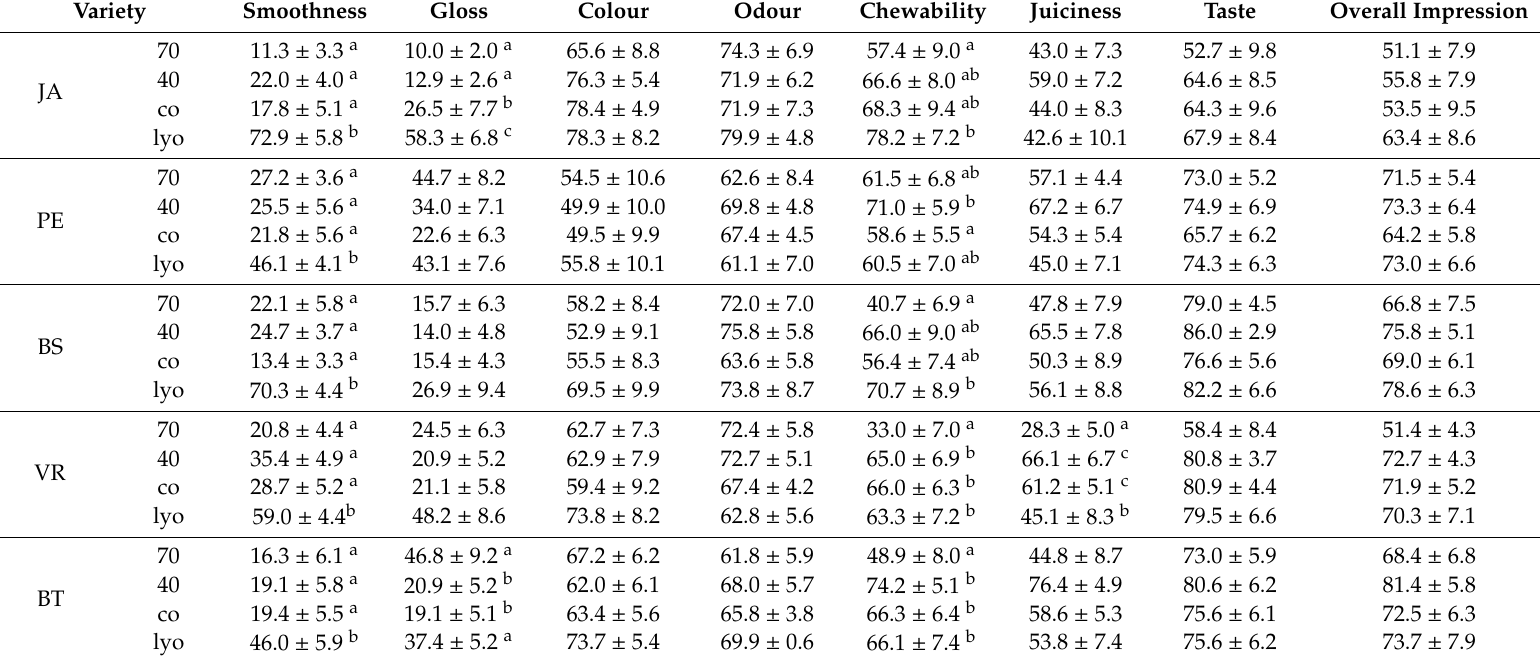
Table 4. Sensory evaluation of varieties depending on drying method (70—70 ◦ C, 40—40 ◦ C, co—combined, lyo—lyophilised). Variety Smoothness Gloss